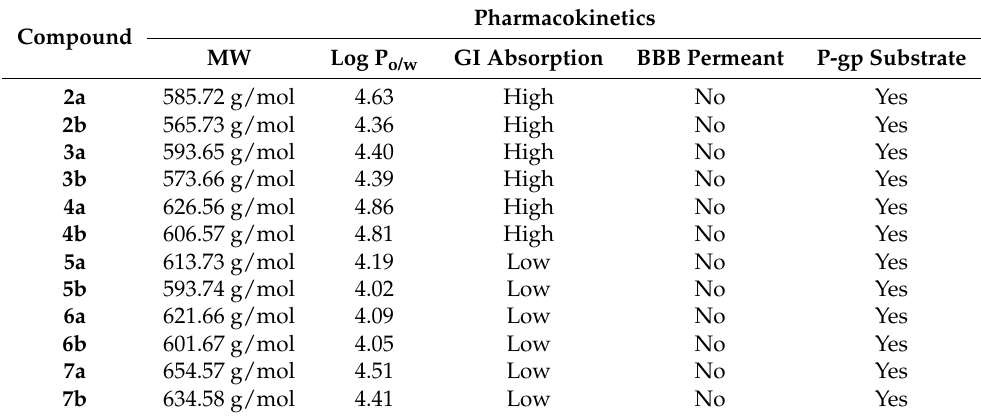
Table 3. Predicted pharmacokinetic properties of investigated compounds using SWISSADME server (accessed on 18 June 2021).